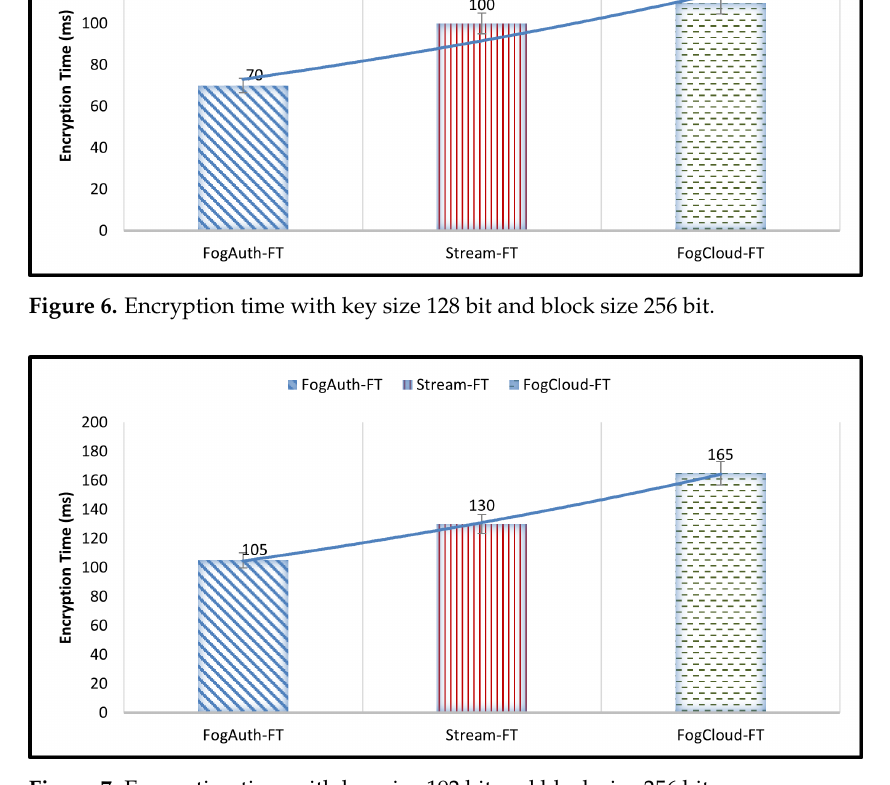
Figure 7. Encryption time with key size 192 bit and block size 256 bit.